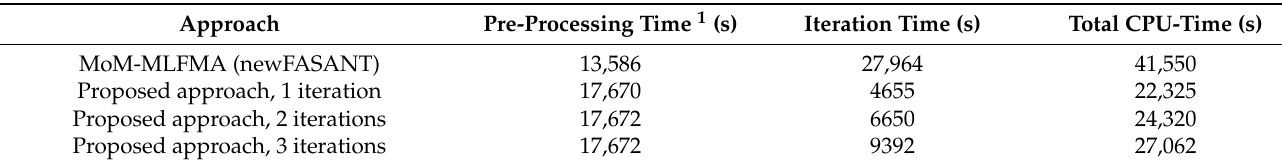
Table 1. Comparison of the CPU-time required by the proposed approach with one, two, and three iterations between domains, and MoM-MLFMA.